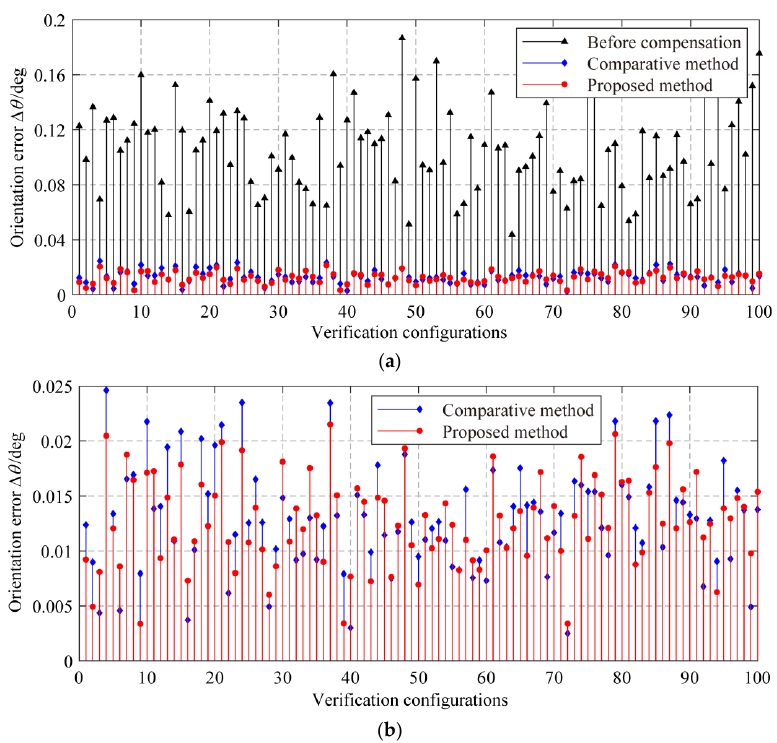
Figure 11. The orientation errors before and after compensation: ( a ) The orientation errors; and ( b ) The magnified graph of ( a ), the residual orientation errors after compensation by two methods. Table 5. Pose errors before and after compensation.